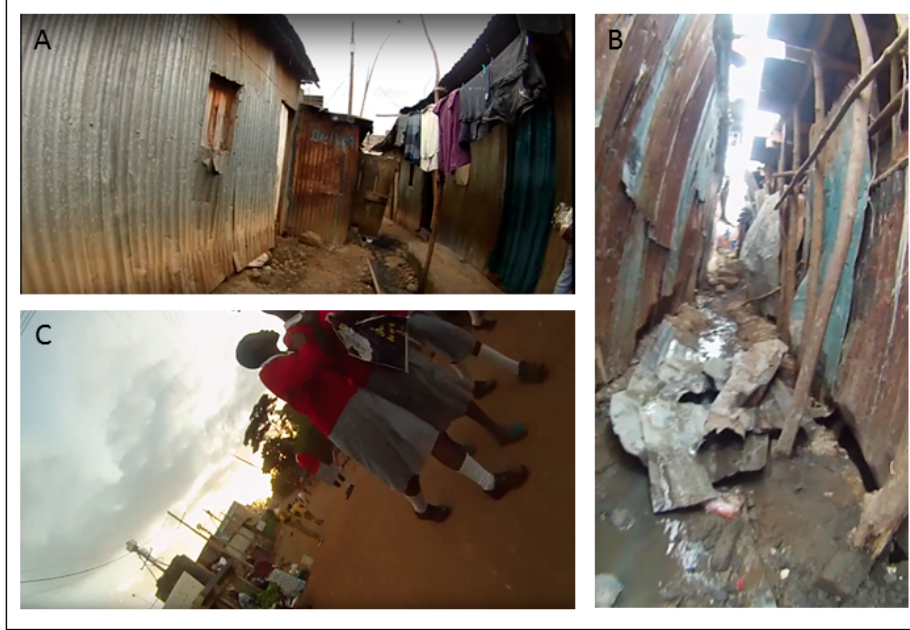
Figure 8. Example images from the three areas of comparison mapped in Figure 7 (white circle = ( A ), yellow rectangle = ( B ), black square = ( C )).